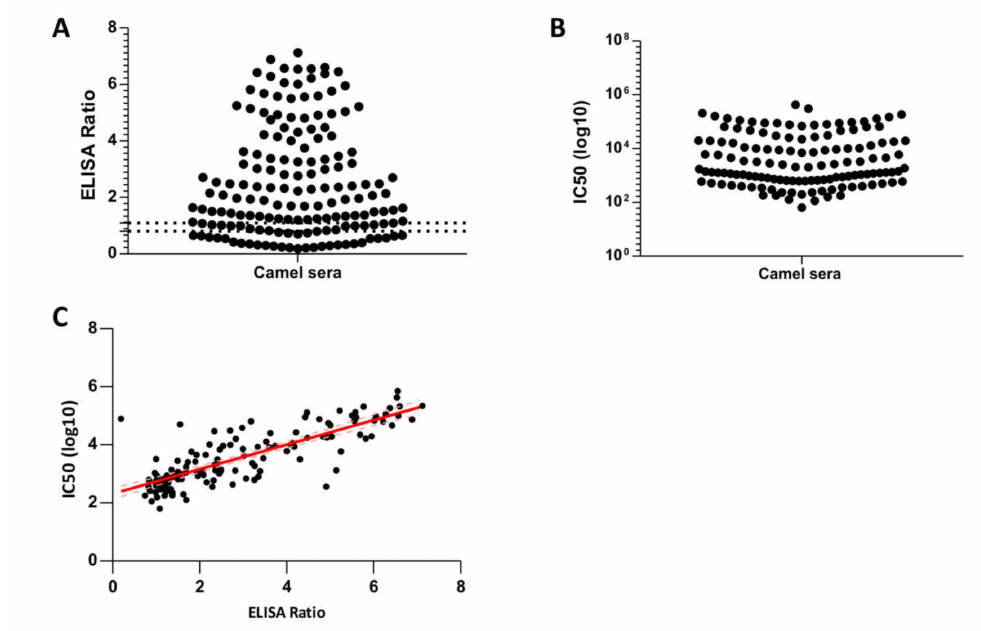
Figure 3. Seroprevalence of MERS-CoV in slaughterhouse camels in Riyadh, 2019. ( A ): Anti-MERS-CoV antibody levels in the tested camel sera using S1-based ELISA Kit. Samples are considered positive when ELISA ratio is above 1.1. ( B ): Neutralizing anti-MERS-CoV antibodies in camel sera were confirmed in all samples that are positive by ELISA. This is shown as 50% inhibitory concentration of MERS pseudotyped viral particles in log scale. ( C ): Correlation between ELISA ratios and titres of neutralizing antibodies by MERSpp assay. Pearson correlation coe ffi cient of 0.80, R squared of 0.65, and a p -value of <